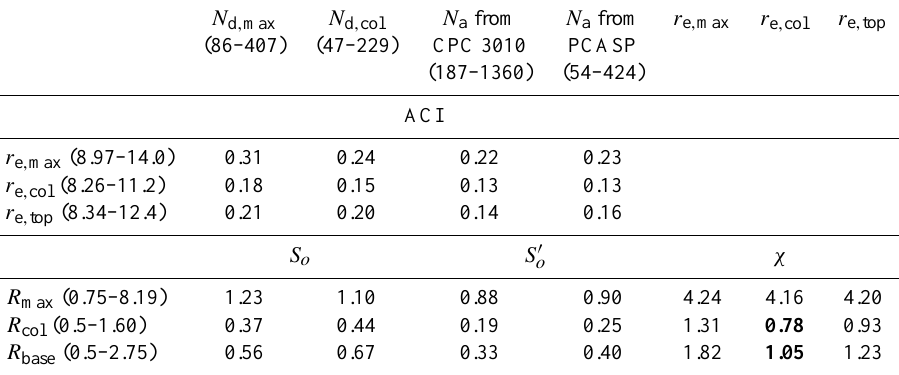
Table 1. Aircraft measurement summary of the sensitivity of ACI, χ , and S o (or S 0 o ) to the choice of how the aerosol proxy ( N d or N a ), R , and r e are quantified. The maximum values (“max”) are quantified as being the average of the 25 points before/after the maximum value (corresponding to a level flight length of ∼ 2.5km). Column-integrated values (“col”) represent the vertical integration of leg-mean values of the respective parameter. Cloud-top and base values (“top” and “base”) represent the leg-mean value below cloud-top and above cloud base, respectively. N a is the leg-mean average of particle concentration below cloud-base, as quantified with both a CPC 3010 ( D p > 10nm) and a PCASP ( D p ∼ 100nm − 2.6µm). Bold signify that those points are not statistically significant with 95% confidence based on the student’s t-test. Numbers in parentheses next to column and row headers correspond to the overall range of those values (Units: N d and N a = #cm − 3 ; r e = µm; R = mmday − 1